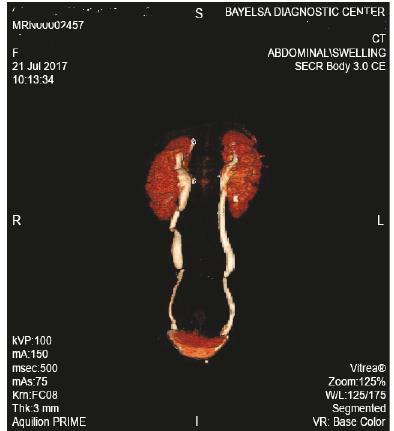
Figure 2: Presurgical evaluation outlining the kidneys, ureters, and bladder on contrast CT scan.